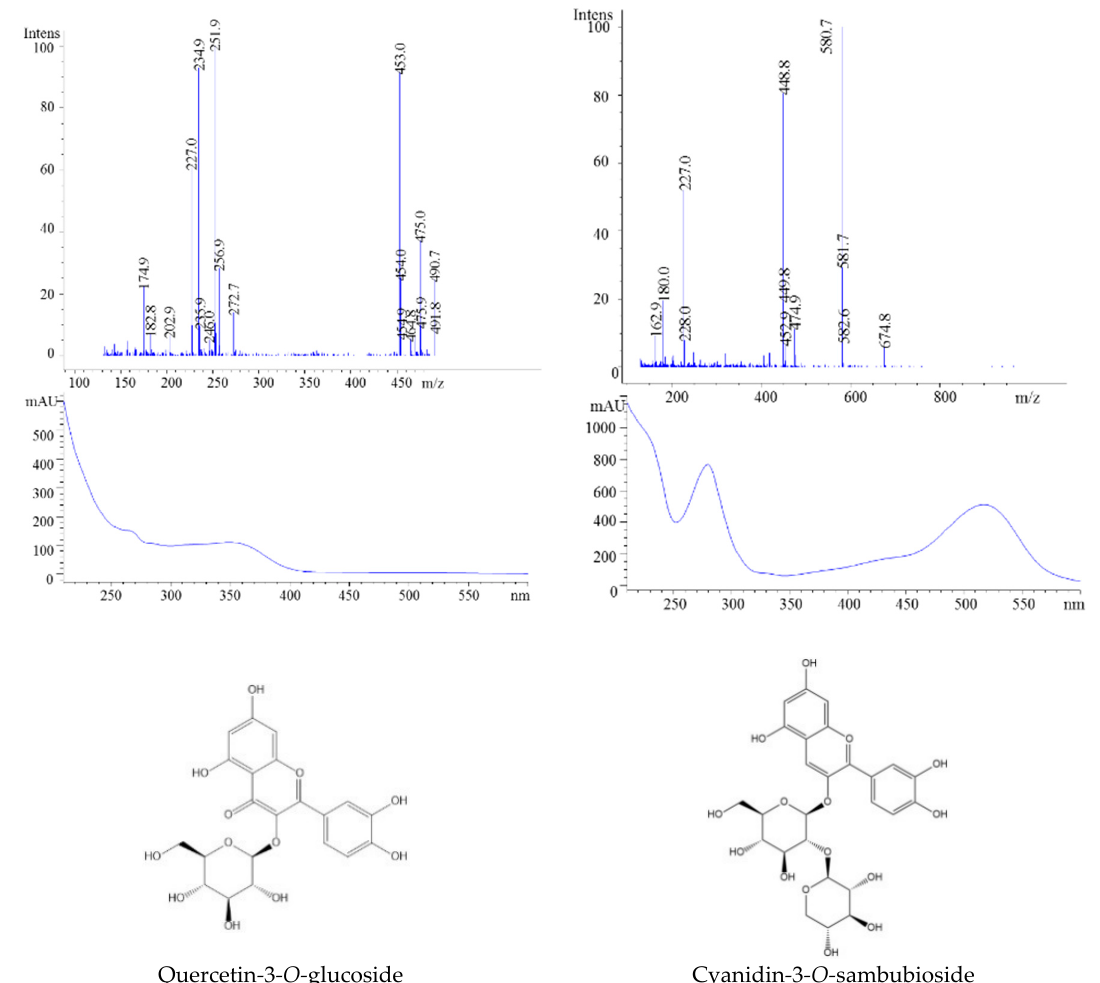
Figure 8 HPLC-MS spectra, UV/vis scanning spectra, and the chemical structures of peaks 2 and 5.